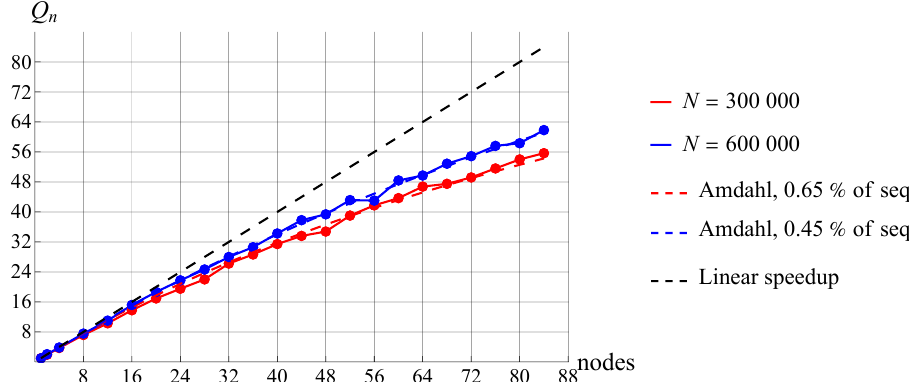
Figure 22. Speedup for different number of 28-core nodes with the MPI technology for flow simulation with different resolution; N is the average number of vortex